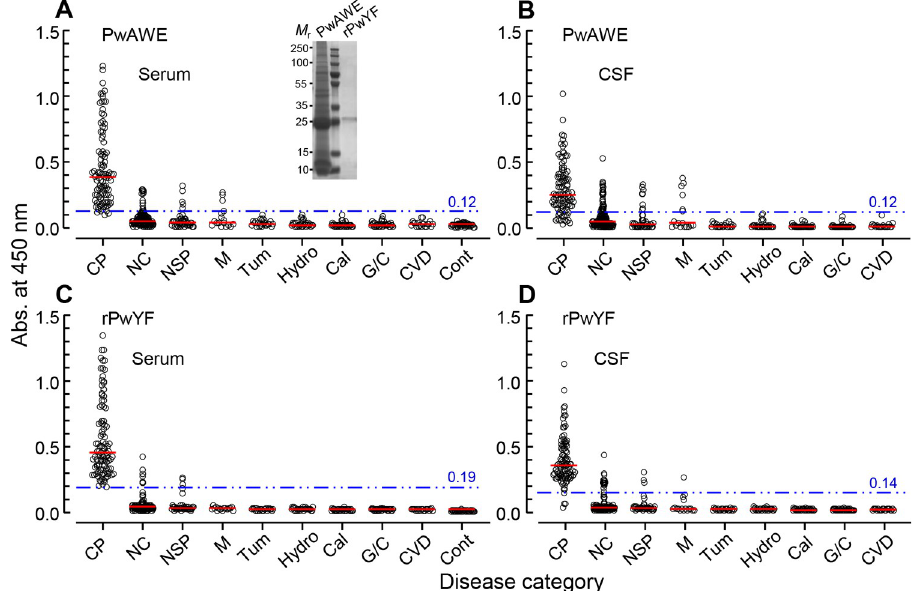
Fig 3. Comparative evaluation of the diagnostic performance of P . westermani adult worm extracts (PwAWE) and recombinant P . westermani yolk ferritin (rPwYF). Specific IgG antibody levels in the serum and CSF samples of patients with various neurological diseases and those in the sera of healthy controls against PwAWE (A and B) and rPwYF (C and D). The y -axis shows the absorbance values of the tested sera and CSFs. The x -axis depicts the following groups: CP, cerebral paragonimiasis ( n = 102 [serum] and n = 101 [CSF]); NC, neurocysticercosis ( n = 149); NSP, neurosparganosis ( n = 42); M, meningitis ( n = 17); Tum, tumor ( n = 27); Hydro, hydrocephalus ( n = 29); Cal, calcification ( n = 31); G/C, granuloma/cystic mass ( n = 31); CVD, cerebrovascular diseases ( n = 20); Cont, healthy controls ( n = 42). The cutoff values determined by receiver operating characteristic analysis shown in Fig 4 are marked by double-dotted blue lines. The red bars indicate the mean absorbance in each group. Inset in panel A shows the protein profiles of PwAWE and rPwYF separated by 15% reducing SDS-PAGE. M r , molecular weight in kDa. ROC curve analysis indicated that rPwYF was a more reliable antigen for the CP serodiagnosis (Fig 4). The relationship between specific IgG antibody levels against PwAWE (r = 0.58) and rPwYF (r = 0.59) in sera and CSFs revealed a positive correlation (S2A and S2B Fig). The anal- ysis of specific antibody levels between serum (r = 0.99) and CSF (r = 0.97) against PwAWE and rPwYF revealed high correlation (S2C and S2D Fig).